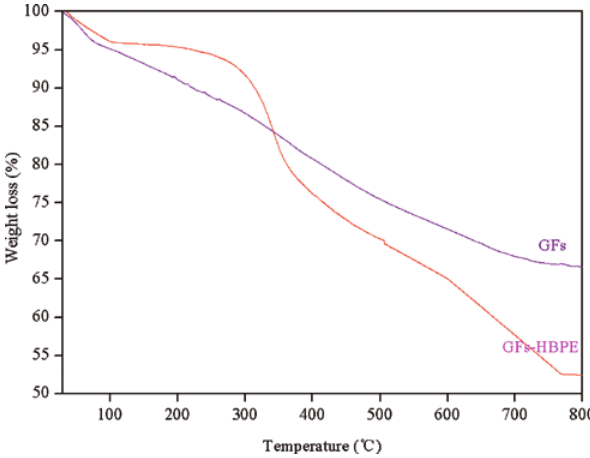
Figure 3: TGA curves of GF and GF-HBPE.